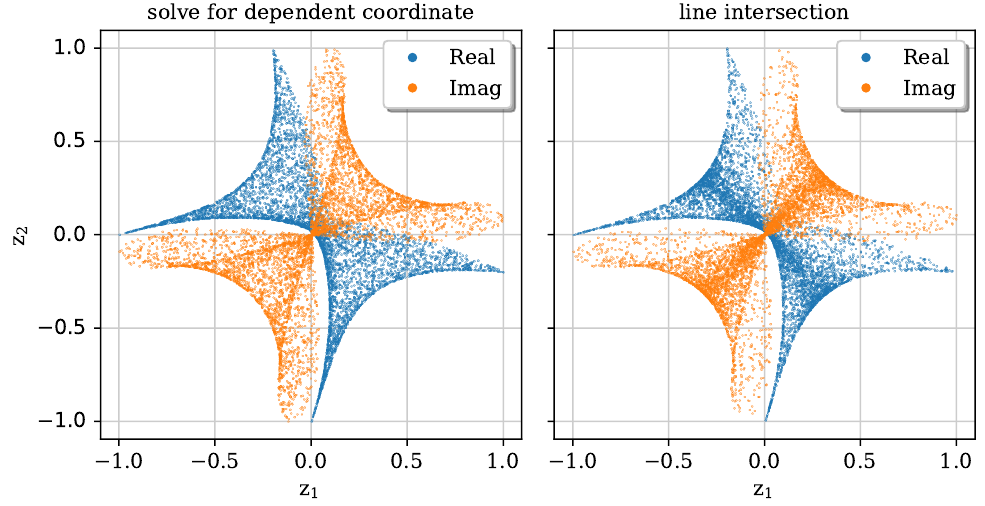
Figure 9 . Scatter-plot comparing real and imaginary parts of the affine coordinates of the variety in P 2 defined by z 3 + z 3 + z 3 + 10 z = 0 , generated using either sampling algorithm introduced 0 z 1 z 2 0 1 2 in section A. The values all lie in the affine patch ˆ U defined by | z = 1 0 1 | , | z 2 | ≤ | z 0 |